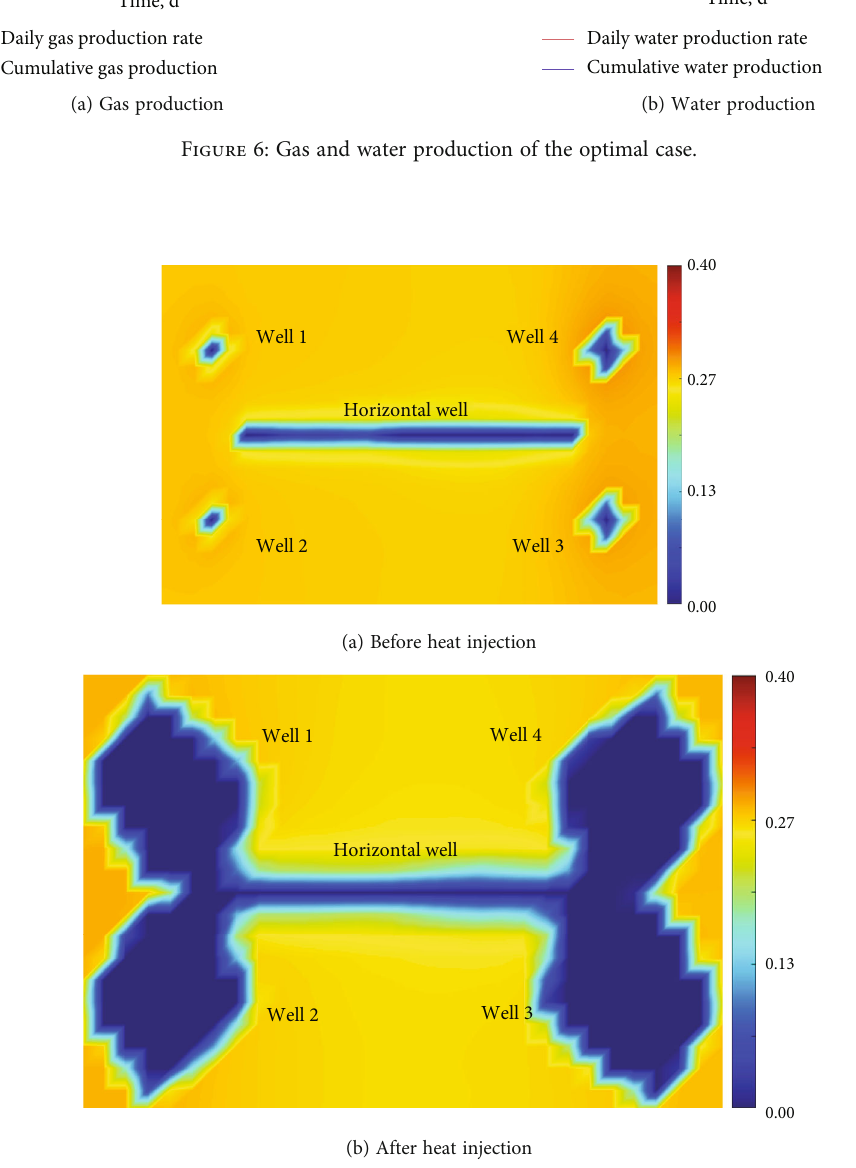
Figure 7: Hydrate saturation